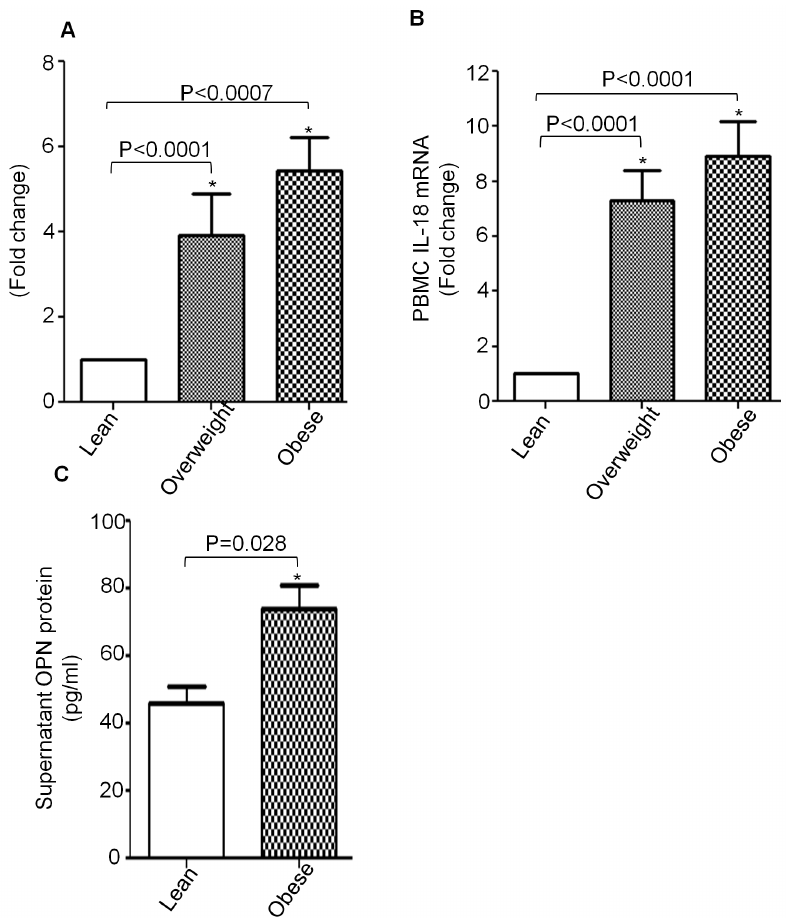
Figure 2. Expression of OPN and IL-18 by PBMCs. Total RNA was extracted from PBMCs of 60 individuals with different BMI (lean: 16; overweight: 20; obese 24). OPN and IL-18 mRNA were measured by real time quantitative PCR. Relative mRNA expression was expressed as fold expression over average of gene expression of lean group. The expression level in lean group was assumed to be 1. Values are presented as mean 6 SE (A and B). PBMCs from three donors of each group were cultured in RPMI supplemented with 2% FBS for 16 hours and then culture supernatants were collected. Secreted OPN protein was determined in the culture supernatants by ELISA (C). Data presented were the means of three independent experiments performed with PBMCs of three donors of each group with 6 SE. lean individuals (obese 73.96 6 6.78, lean 45.73 6 5.03 pg/ml; P =0.028).